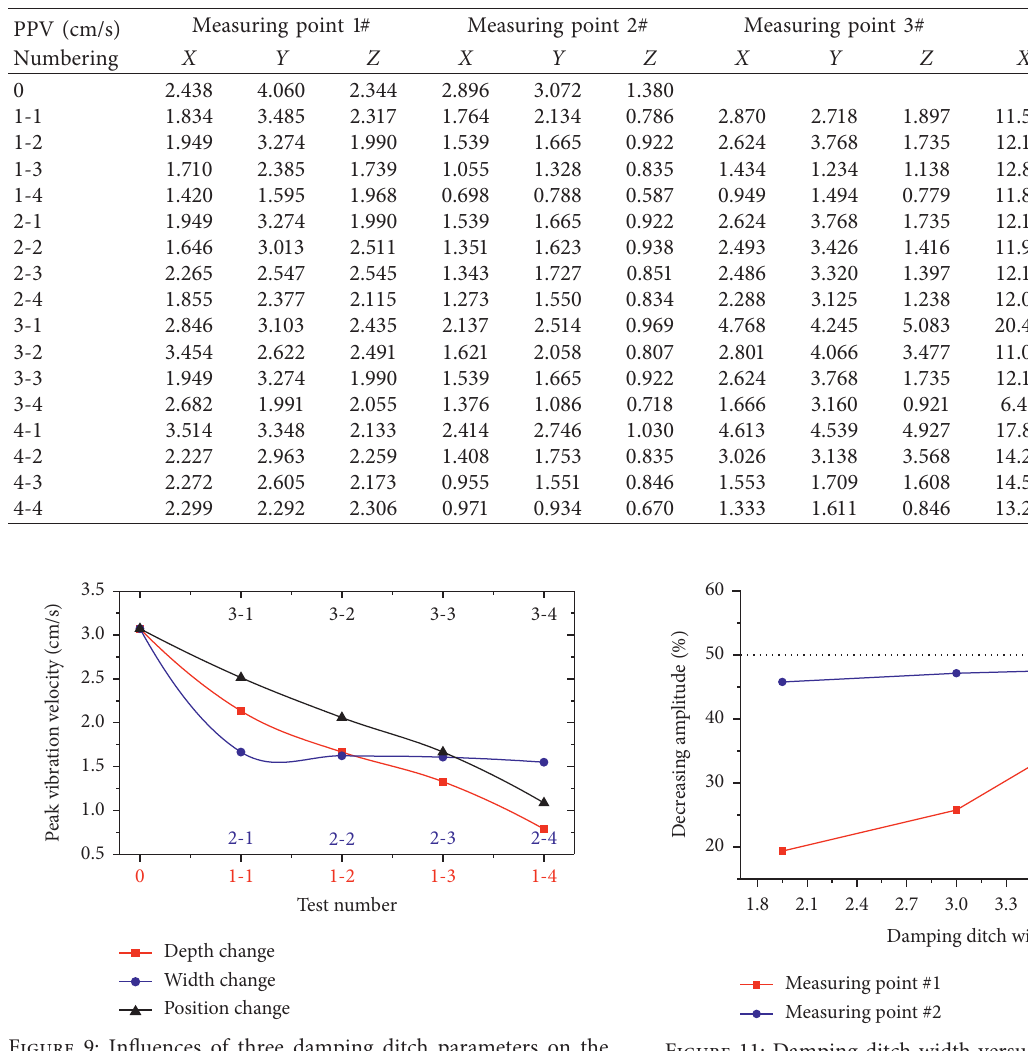
Table 6: PPV of numerical calculation in three directions.